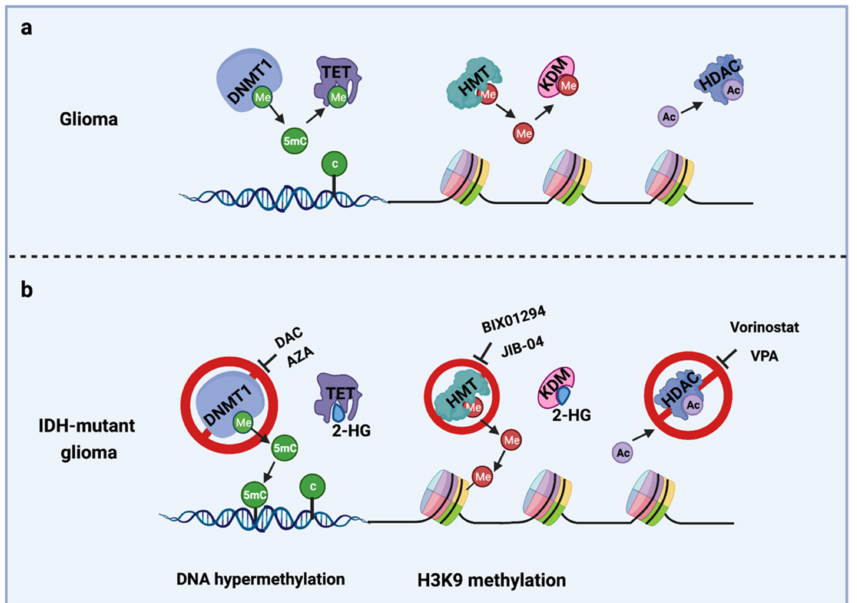
Figure 1. Epigenetic alterations induced by IDH mutations and potential drug targets for TMZ combination therapy. ( a ) Cellular epigenetic regulation without IDH mutation; ( b ) cellular epigenetic alterations in IDH-mutant